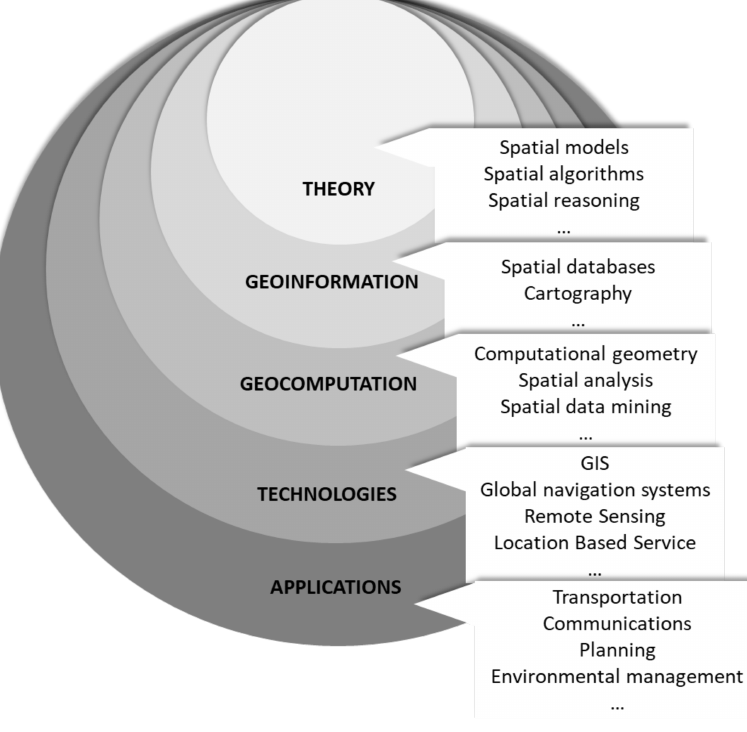
Figure 1. The traditional representation of the geoinformatics layers (from reference [2], modified). GIS: geographical information